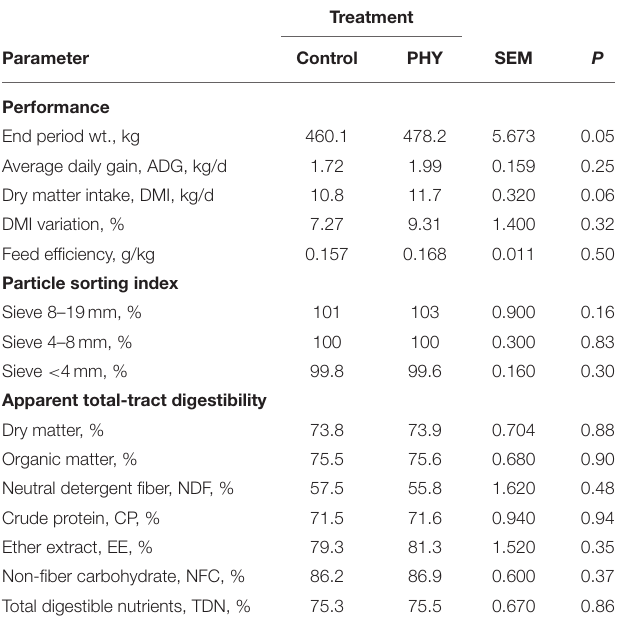
TABLE 3 | Comparison of dry matter intake, average daily gain, particle sorting index, and apparent total tract digestibility of crossbred finishing bulls during finishing early finishing period: from day 26 to 57.